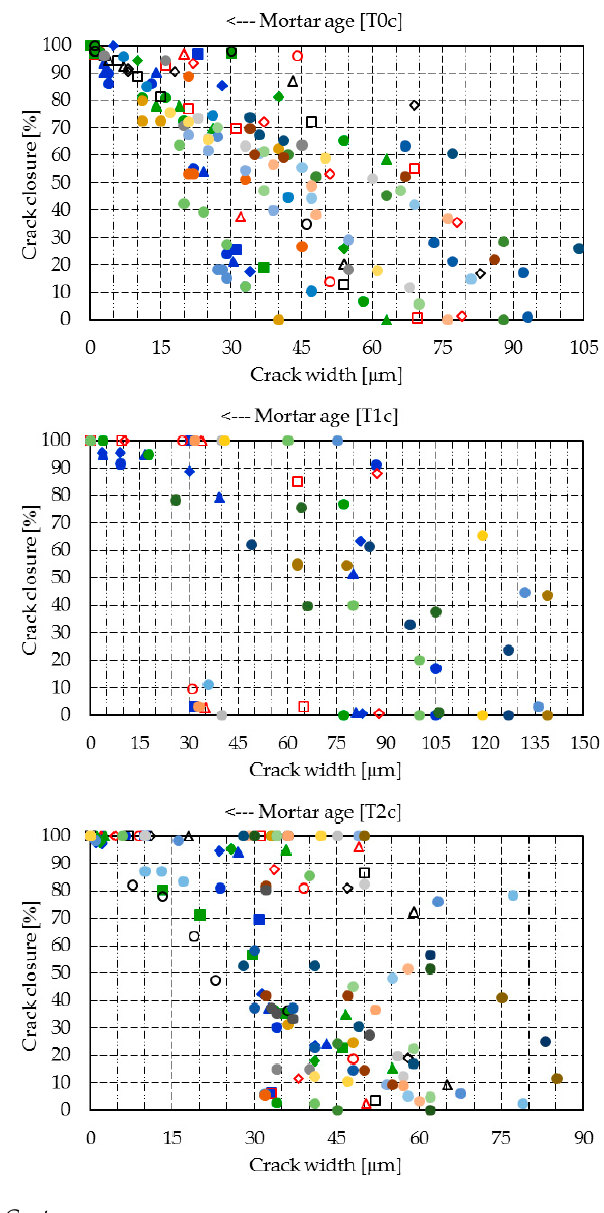
( b ) Figure 8. Segmented crack closures—markers correspond to the readings of each crack segment: ( a ) T0r–T3r; ( b ) T0c–T3c.